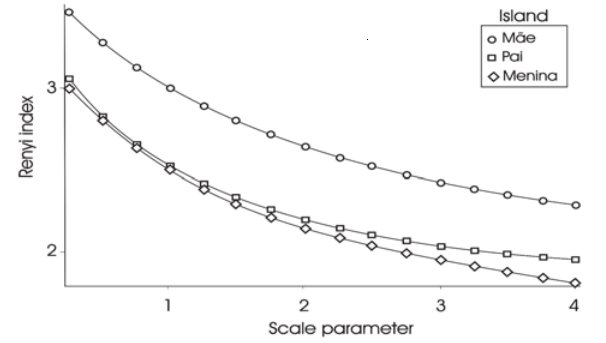
Fig. 2. Renyi´s diversity ordination scale parameter compar- ing Menina, Mãe and Pai Islands.